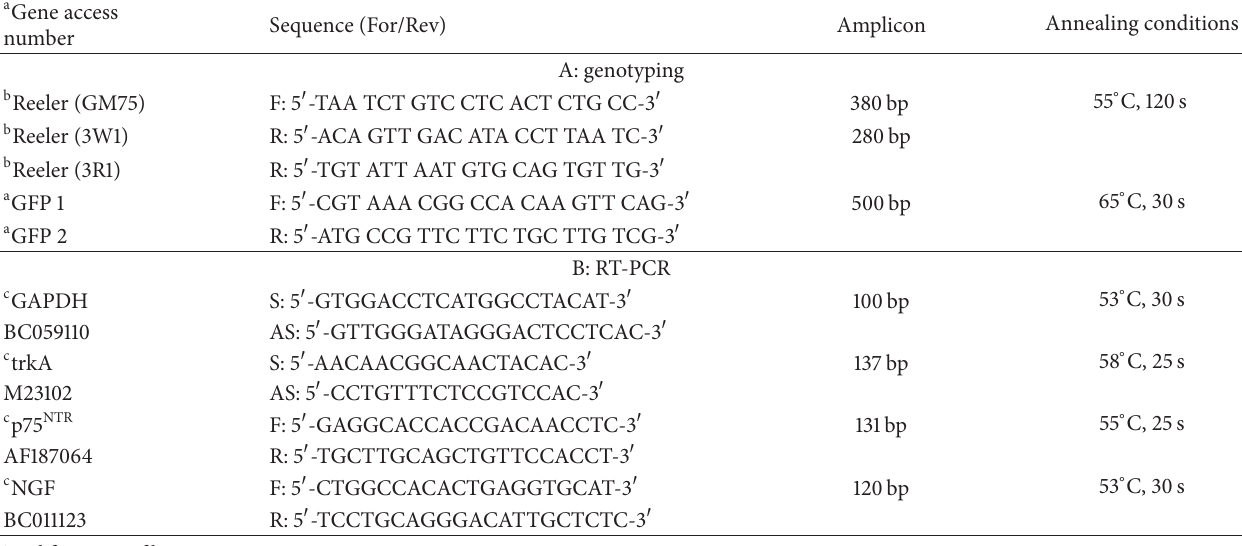
Table 1: Primers for genotyping (A) and for real time PCR (B) used in the study. a Gene